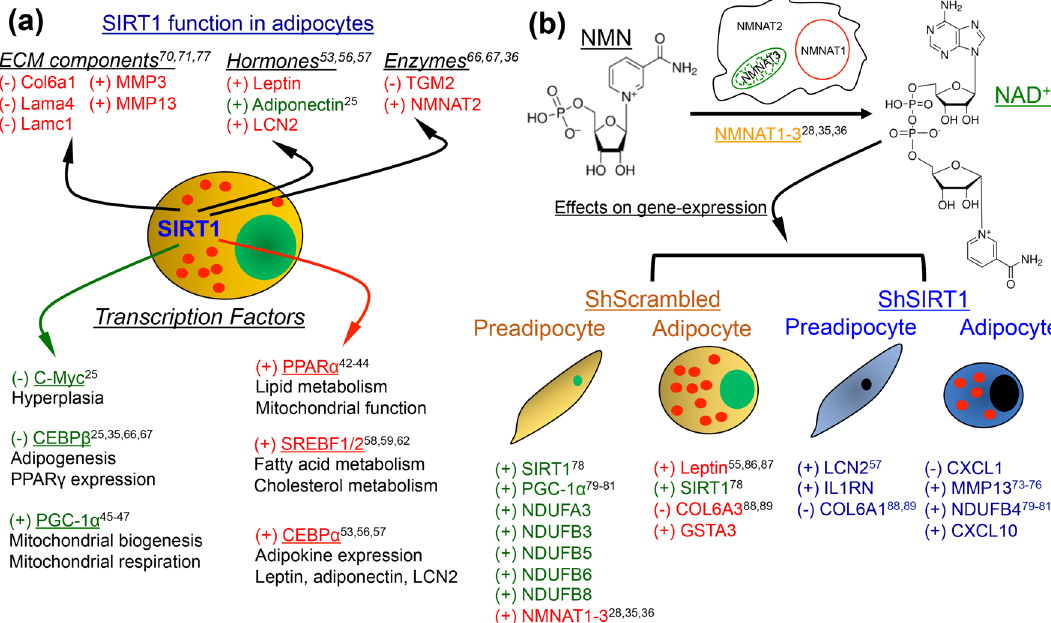
Figure 9. NAD + -SIRT1 signaling fine-tunes the activity of key transcription factor networks to promote adipocyte function. ( a ) Schematic summary of the data obtained by combining quantitative proteomics and gene-expression analysis in adipocytes. Positive or negative effect of SIRT1 on the expression levels of individual molecules (top) or transcription factor pathways (bottom) is indicated by ‘+’ or ‘−’ sign, respectively. Molecules highlighted in red represent those whose interaction with SIRT1 to our knowledge has not been previously reported in the context of adipogenesis, adipose tissue function, or obesity. Evidence of an interaction between SIRT1 and molecules highlighted in green can be found in the literature. ( b ) Schematic summary of the effects of supplementation with NMN on gene-expression in ShScrambled and ShSIRT1 (pre)adipocytes. Positive or negative effect of NMN supplementation on the expression of indicated genes is indicated by ‘+’ or ‘−’ sign, respectively. Genes highlighted in red represent those whose SIRT1-dependence in response to NMN has not been previously reported, while those in green represent molecules whose association with NAD + -SIRT1 signaling is known. Molecules highlighted in blue represent those whose expression was altered by NMN in SIRT1-depleted (pre)adipocytes, which may reflect residual SIRT1 function or involvement of other NAD + - dependent proteins. Chemical structures of NMN and NAD + are shown, and conversion of NMN to NAD + occurs intracellularly by the action of NMNAT enzymes. The numbers indicate citations that link each molecule or pathway to the relevant section in